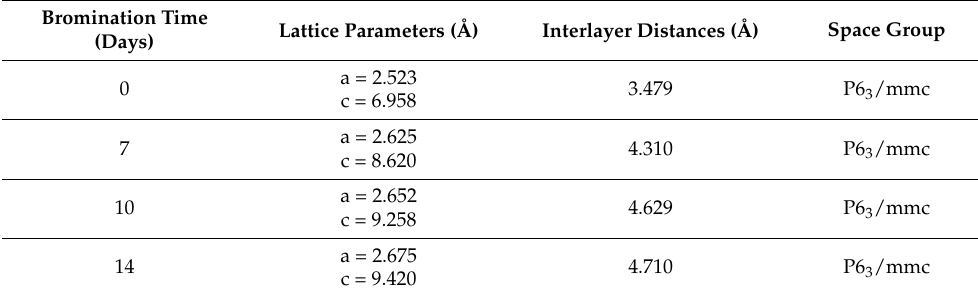
Figure 5. Br3d region for samples after the bromination process. Table 4. XRD parameters for selected MWCNT-Br n